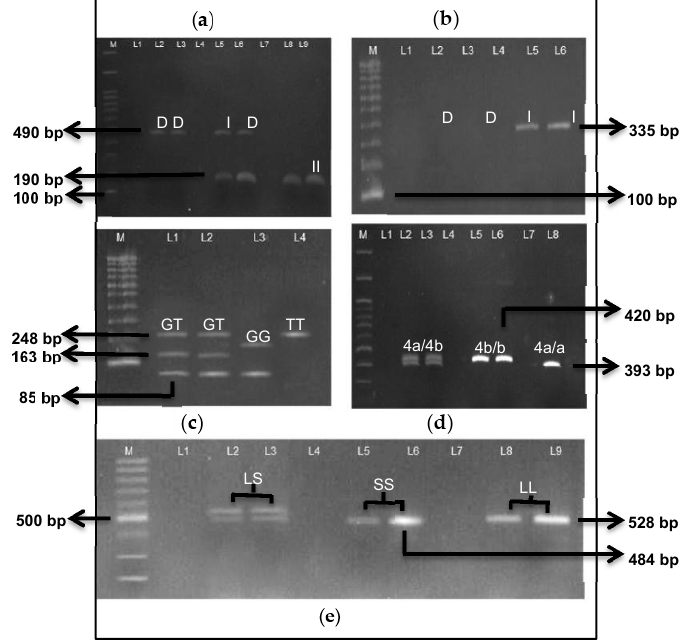
Figure 1. ( a ) Amplification of ACE I/D in 2% agarose gel. DD genotype was denoted by 490 bp band (Lane 2 & 3) and II genotype was shown by 190 bp band (Lane 8 & 9) whereas ID genotype showed both 190 bp and 490 bp bands (Lane 5 & 6). ( b ) Mistyping of ACE I/D . I allele showed 335 bp band (Lane 5 & 6) whereas DD genotype was proven by the absence of any band (Lane 2 & 3). ( c ) Restriction fragments in 4% agarose gel. Heterozygous type (GT genotype) showed three bands consists of 85 bp, 163 bp and 248 bp (Lane 1 & 2). GG genotype was showed by 85 bp and 163 bp bands (Lane 3). Lane 4 shows the undigested 248 bp band, which was TT genotype (mutant). ( d ) PCR product of eNOS 4b/4a amplification in 2% agarose. Heterozygous sample (4a/b) was shown by both 393 bp and 420 bp bands (Lane 2 & 3). Wild type (4b/b) was shown by a 420 bp band (Lane 5 & 6). 393 bp band indicated